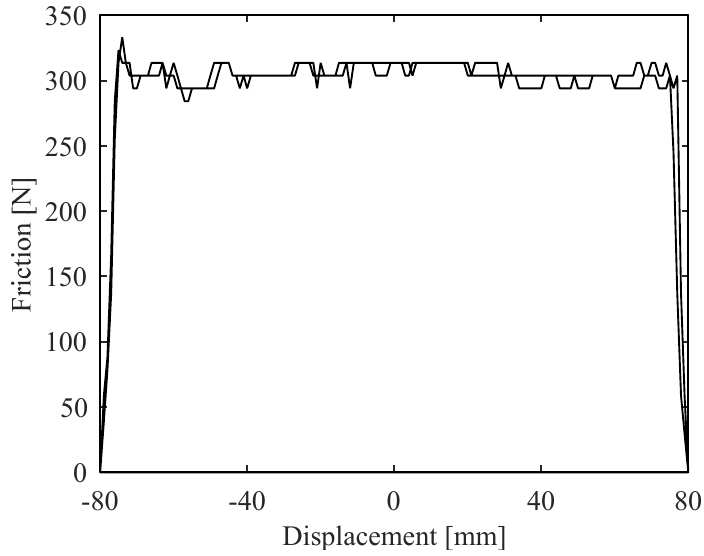
Figure 10. Friction of the MRA.